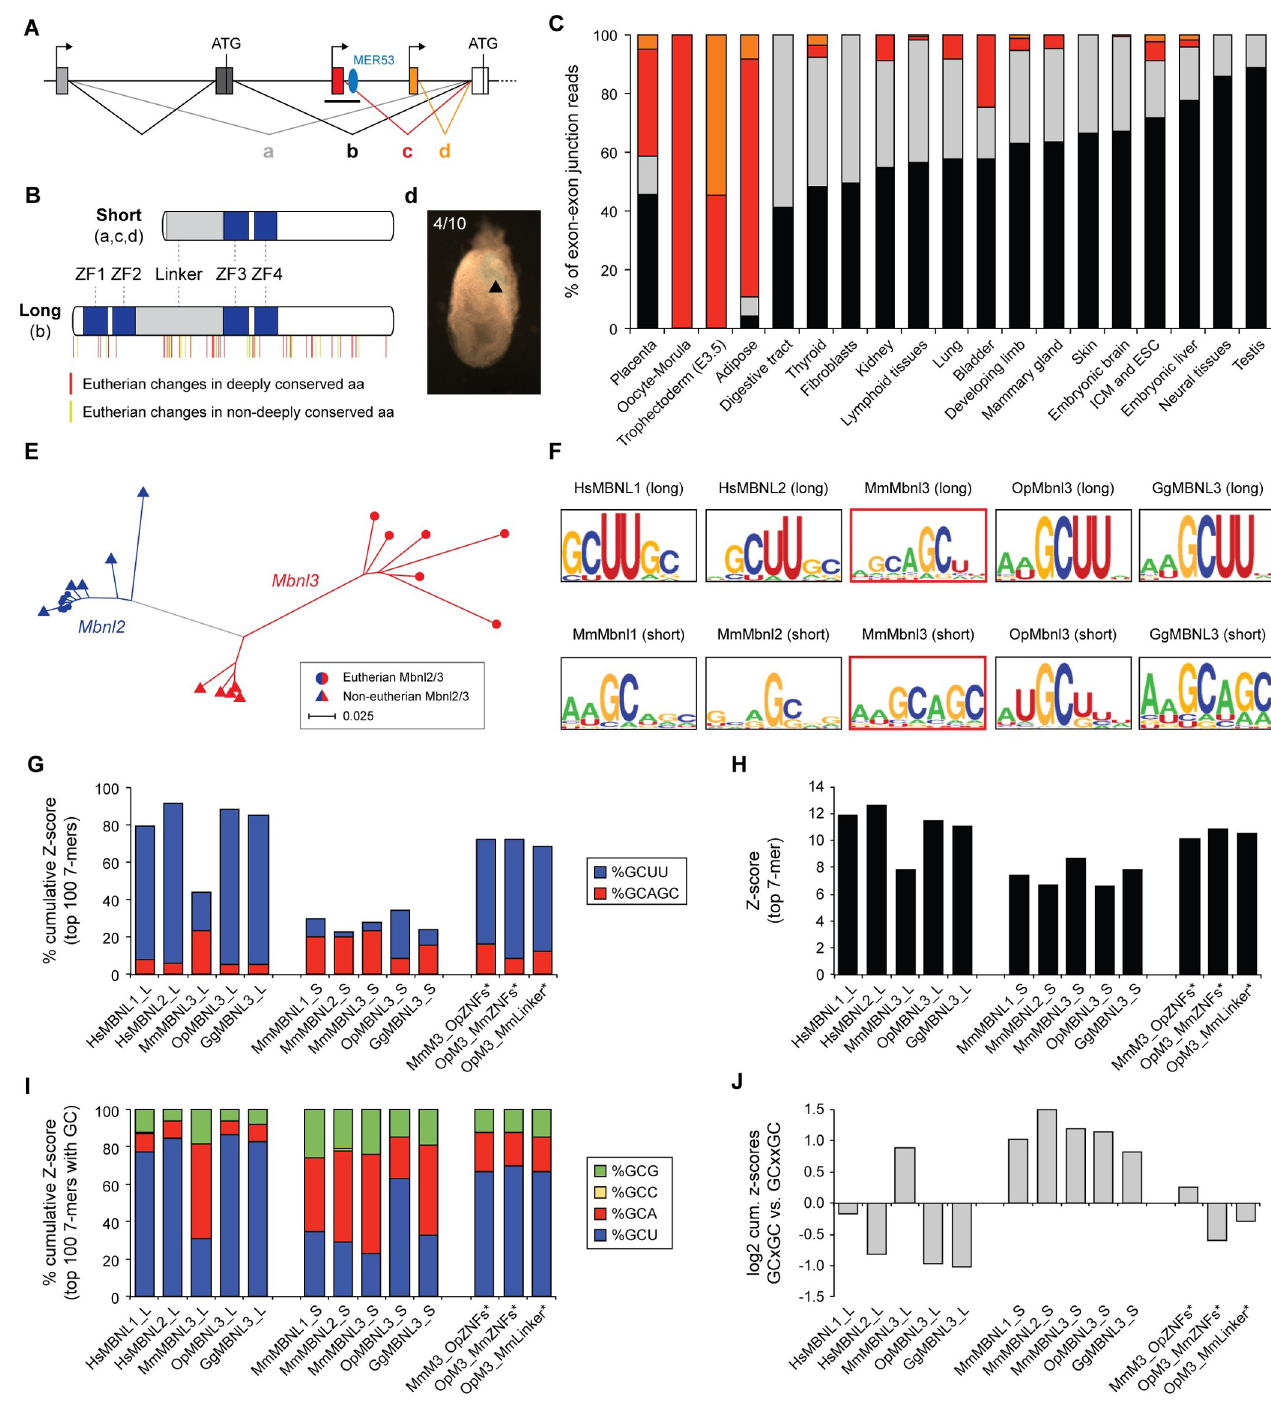
Fig 2. Molecular evolution of Mbnl3 in eutherians. (A) Schematic showing alternative splicing events and transcriptional (arrow) and translational (ATG) start sites leading to long and short MBNL3 isoform production. Splice junctions corresponding to transcripts that code for the long (b) and short (a, c, d) isoforms are indicated. Ancestral (black/gray), eutherian-specific (red) and mouse-specific (orange) TSSs and the location of the DNA transposon MER53 (blue) are also shown. (B) Diagram showing long and short Mbnl3 isoforms and the location of eutherian-specific aa changes. Zinc finger domains are shown in blue. Sequence alignment is shown in S3 Fig. (C) Quantification of the relative usage of the splice junctions highlighted in (A) across a range of mouse tissues. (D) Transgenic analysis of a putative Mbnl3 promoter region. A approximately 8-kb region surrounding the eutherian-specific TSS indicated by the black bar in (A) produced lacZ staining in the trophoblast of 4/10 injected embryos at E7.5. (E) Phylogenetic tree showing the degree of MBNL3 (red)